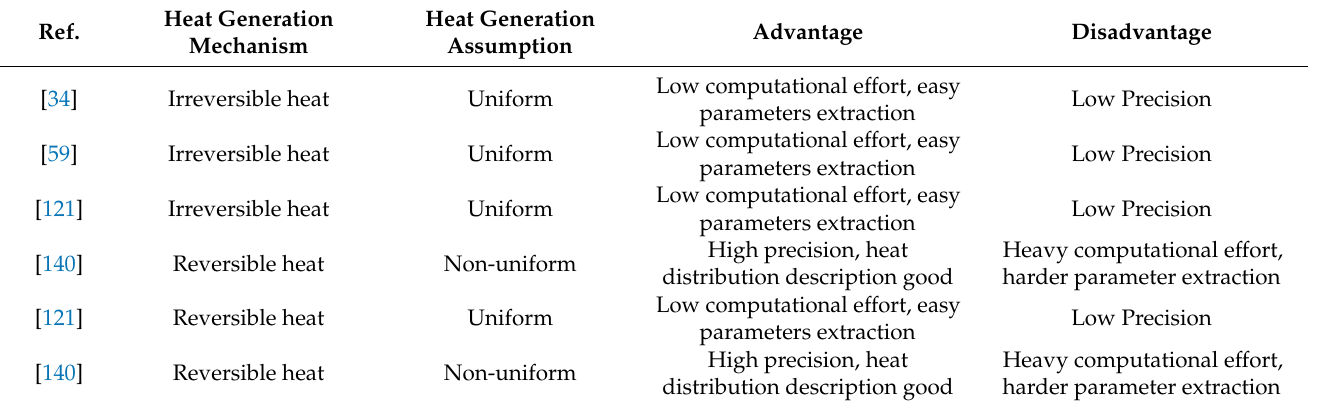
Table 2. The heat generation estimation methods for LiCs in the literature.